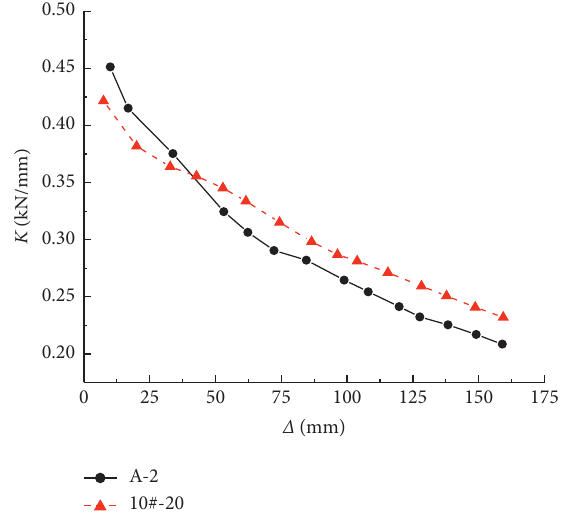
Figure 17: Stiffness degradation curves between specimen A-2 and model 10#-20. Table 5: Group B models.